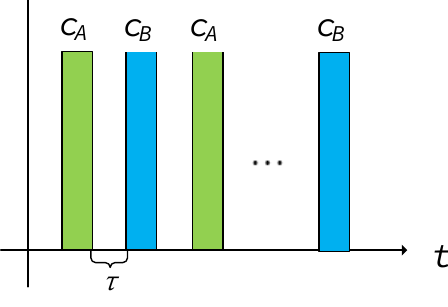
Figure 2. Pulse Alternate Transmission